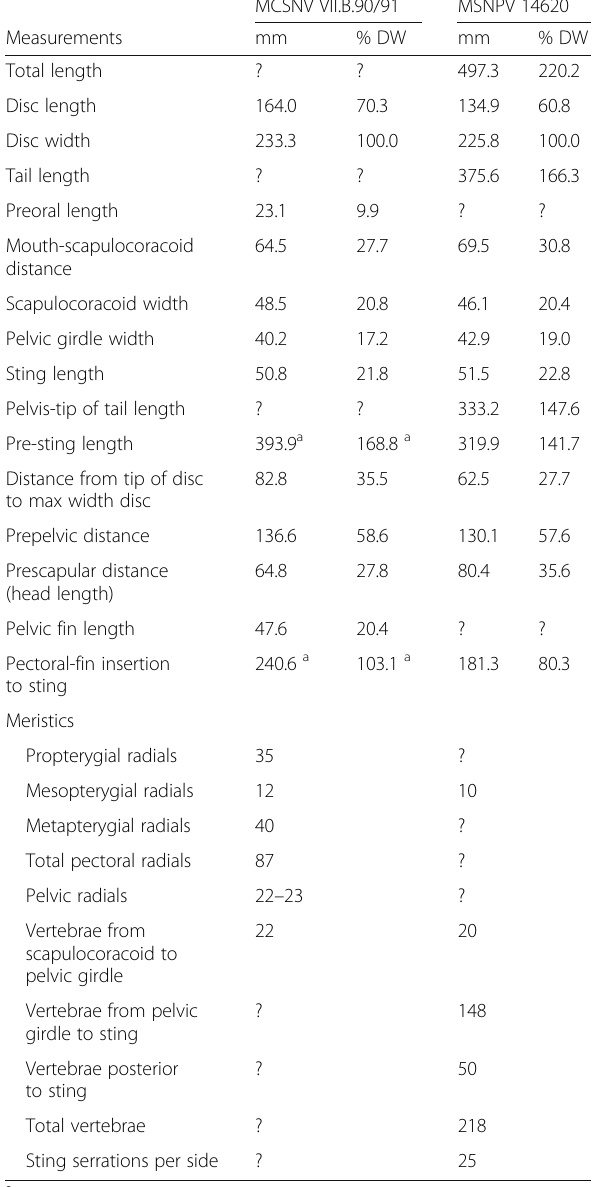
Table 1 Morphometric and meristic data of the two specimens of Promyliobatis gazolai